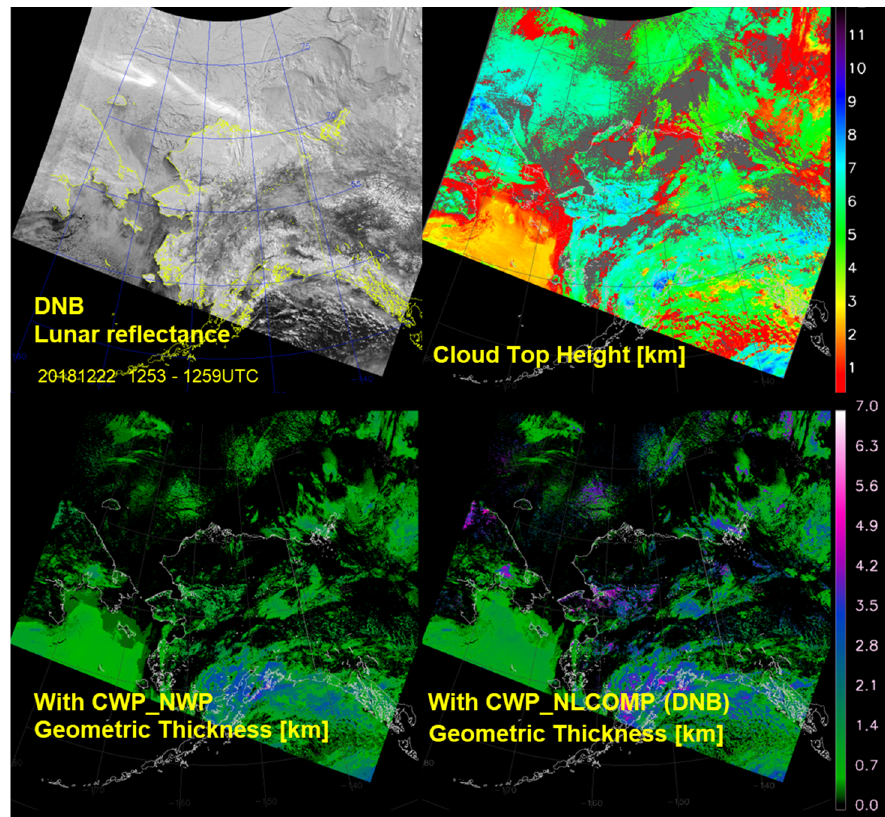
Figure 15. Comparison of CGT values showing deeper cloud thickness can be retrieved by using VIIRS Day/Night Band data ( bottom right ) over conventional CGT nighttime retrieval with NWP- based CWP input ( bottom left ) over Alaska. The top panels show VIIRS DNB lunar reflectance and CTH from S-NPP at 1253 UTC on 22 December 2018.